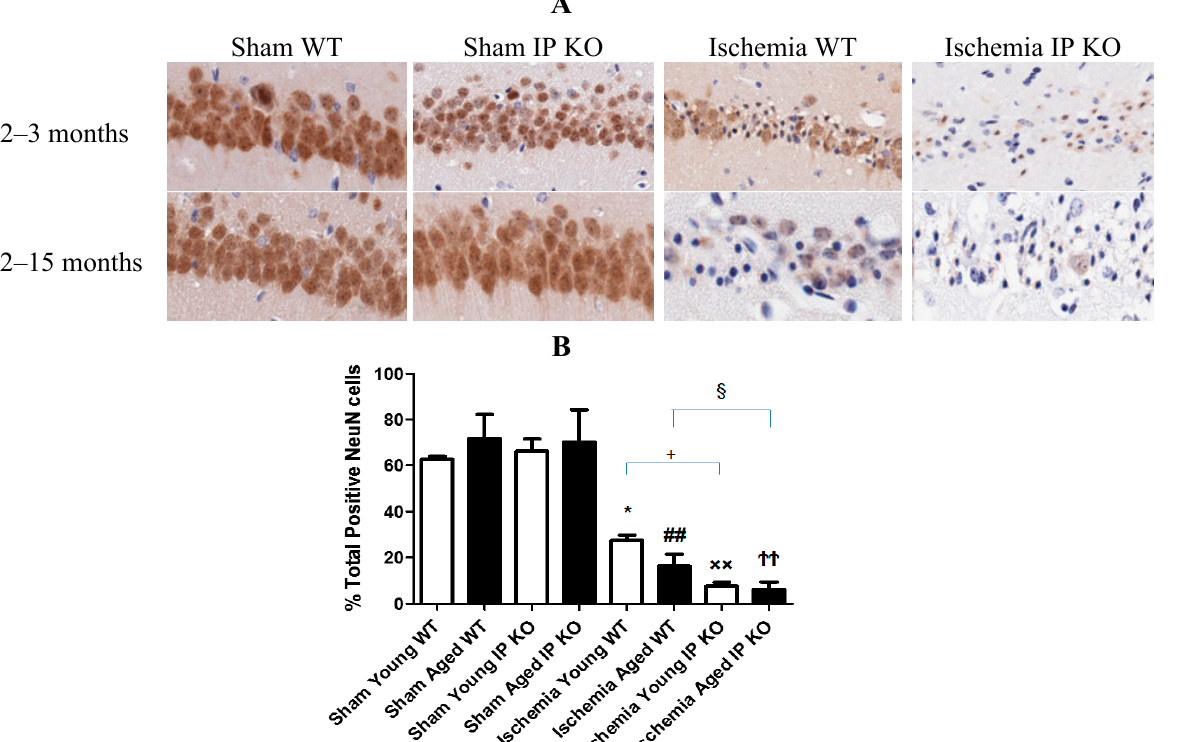
Figure 3. NeuN staining in young and aged WT and IP KO sham and ischemic mice after 12 min global cerebral ischemic insult. ( A ) Representative images of brain sections show NeuN immunostaining in young and aged WT and IP KO sham and ischemic mice. ( B ) Quantification of NeuN-positive cells in the hippocampal CA1 subfield on day 7 after ischemia, comparing ischemic IP KO groups with their sham and ischemic controls ( n = 3 per group). * p < 0.05, ×× p < 0.01, ## p < 0.01, ϮϮ p < 0.01 for Ischemia vs. Sham; + p < 0.05, § p < 0.05 for Ischemia IP KO vs. Ischemia WT.